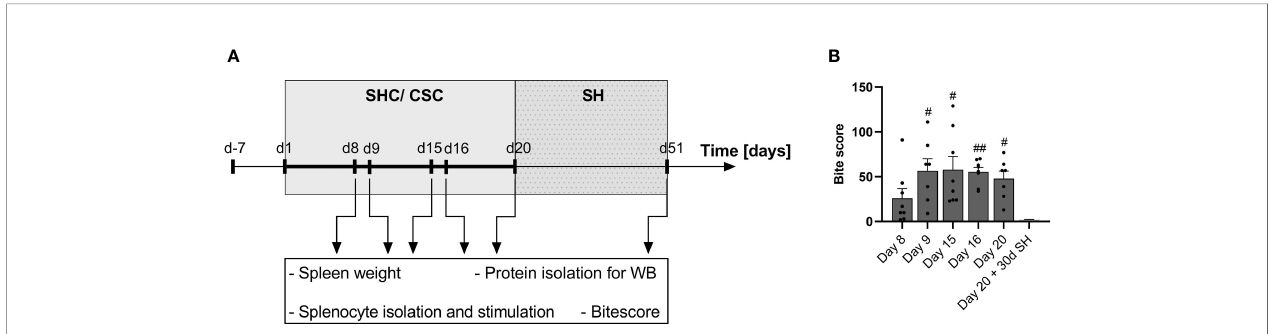
FIGURE 1 | Experimental timeline and bite score. (A) Schematic drawing of the experimental timeline. Mice arrived on day (d) -7 and were single-housed for one week. From day 1 on, mice were either kept as single-housed controls (SHC) or exposed to the chronic subordinate colony housing (CSC) paradigm. Four CSC mice were housed together with a larger, dominant CD-1 mouse in order to induce chronic psychosocial stress. To avoid habituation, CSC mice were exposed to a novel aggressor mouse on days 8 and 15 of the CSC paradigm. Mice were sacri fi ced in the morning of day 8 (right before exposure to the 2 nd aggressor), day 9 (24 h after exposure to the 2 nd aggressor), day 15 (right before exposure to the 3 rd aggressor) and day 16 (24 h after exposure to the 3 rd aggressor) and day 20. One set of animals was single housed (SH) on day 20 for 30 consecutive days and then euthanized in the morning of day 51. After euthanasia, spleen weight and the severity of bite wounds were assessed. Additionally, splenocytes were isolated and stimulated, and used for further protein isolation for Western Blot (WB) analysis. (B) Bite score to assess the severity of bite wounds in CSC mice euthanized on days 8, 9, 15, 16 and 20 of the CSC paradigm or 30 days after stressor termination. Data are presented as mean + SEM including individual values. # P ≤ 0.05, ## P ≤ 0.01 versus day 20 + 30d